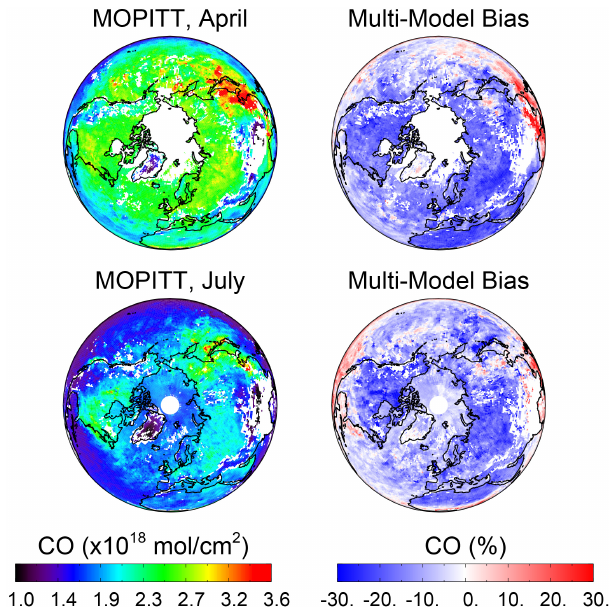
Figure 5. MOPITT total tropospheric CO column (left) and multi- model mean percent bias (right) for April (top) and July (bottom) 2008. The models have had the MOPITT averaging kernels applied and retrievals with DOFS less than 1 removed. The multi-model mean CO is calculated from all 10 global models and the MATCH hemispheric